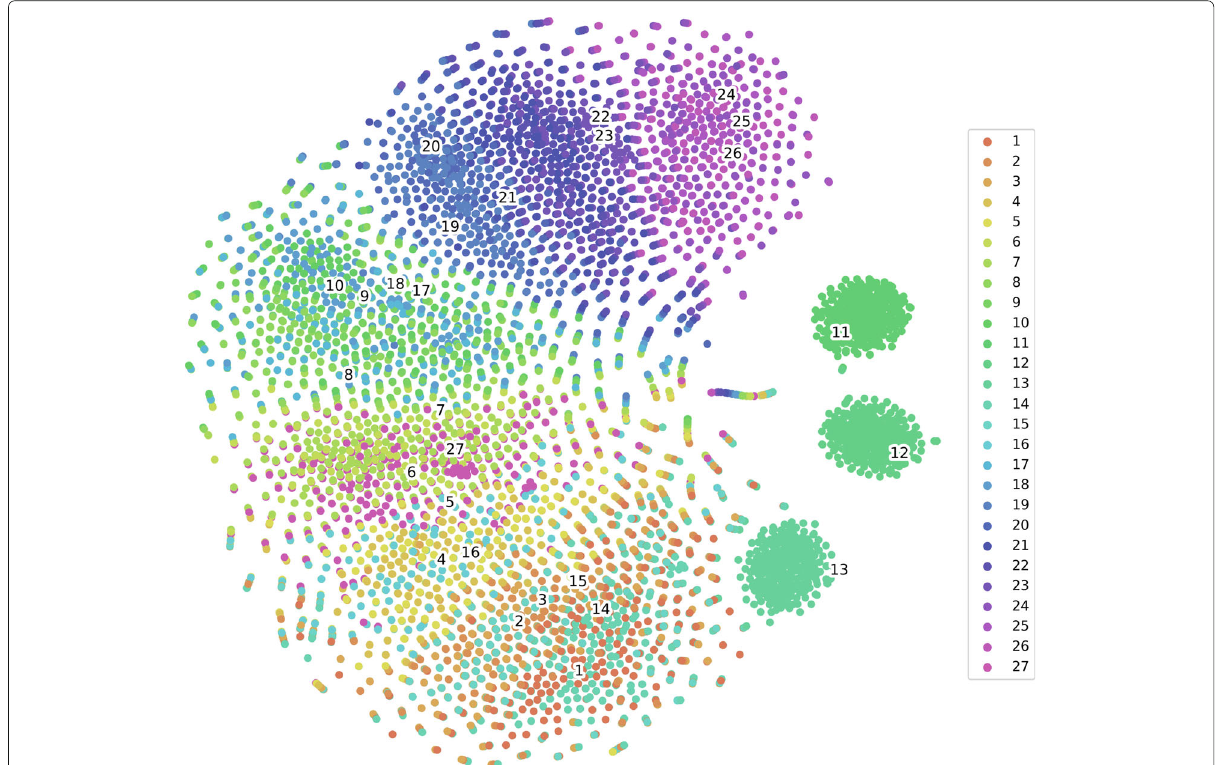
Fig. 8 t-SNE visualization of x-vectors extracted from the speech of the real and virtual speakers, where Speaker 27 is the real